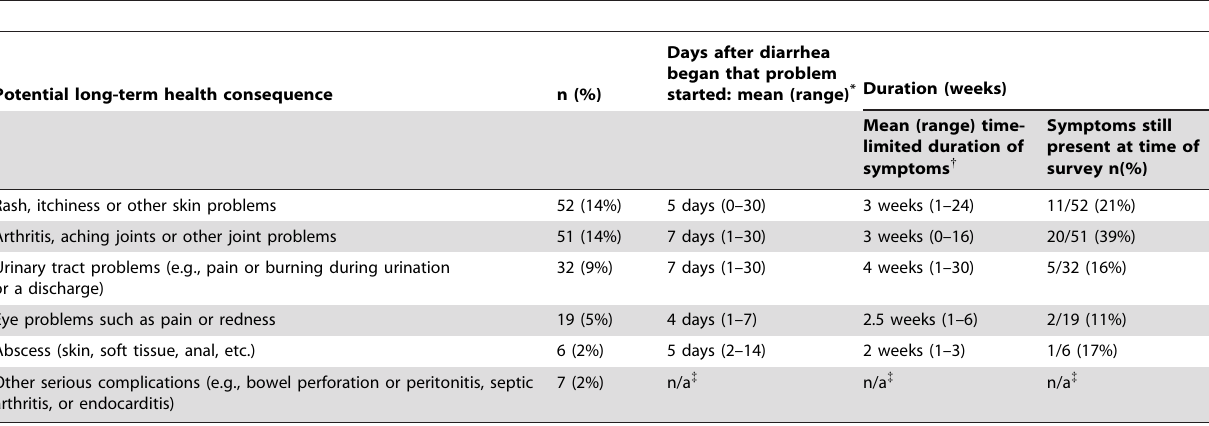
Table 2. Potential long-term health consequences of Salmonella infection reported by survey respondents that were ill with diarrhea ( $ 2 loose stools during a 24-hour period) (n= 369) during an outbreak of salmonellosis, Alamosa, Colorado 2008.